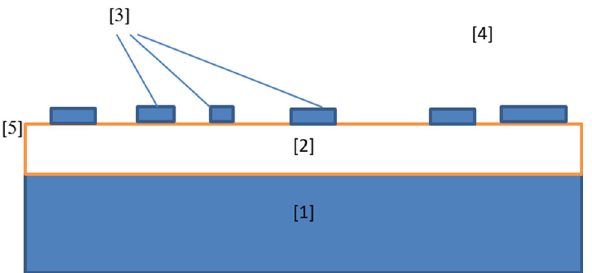
Fig. 4 Schematic of the basic design of a shield system by heavy elec-